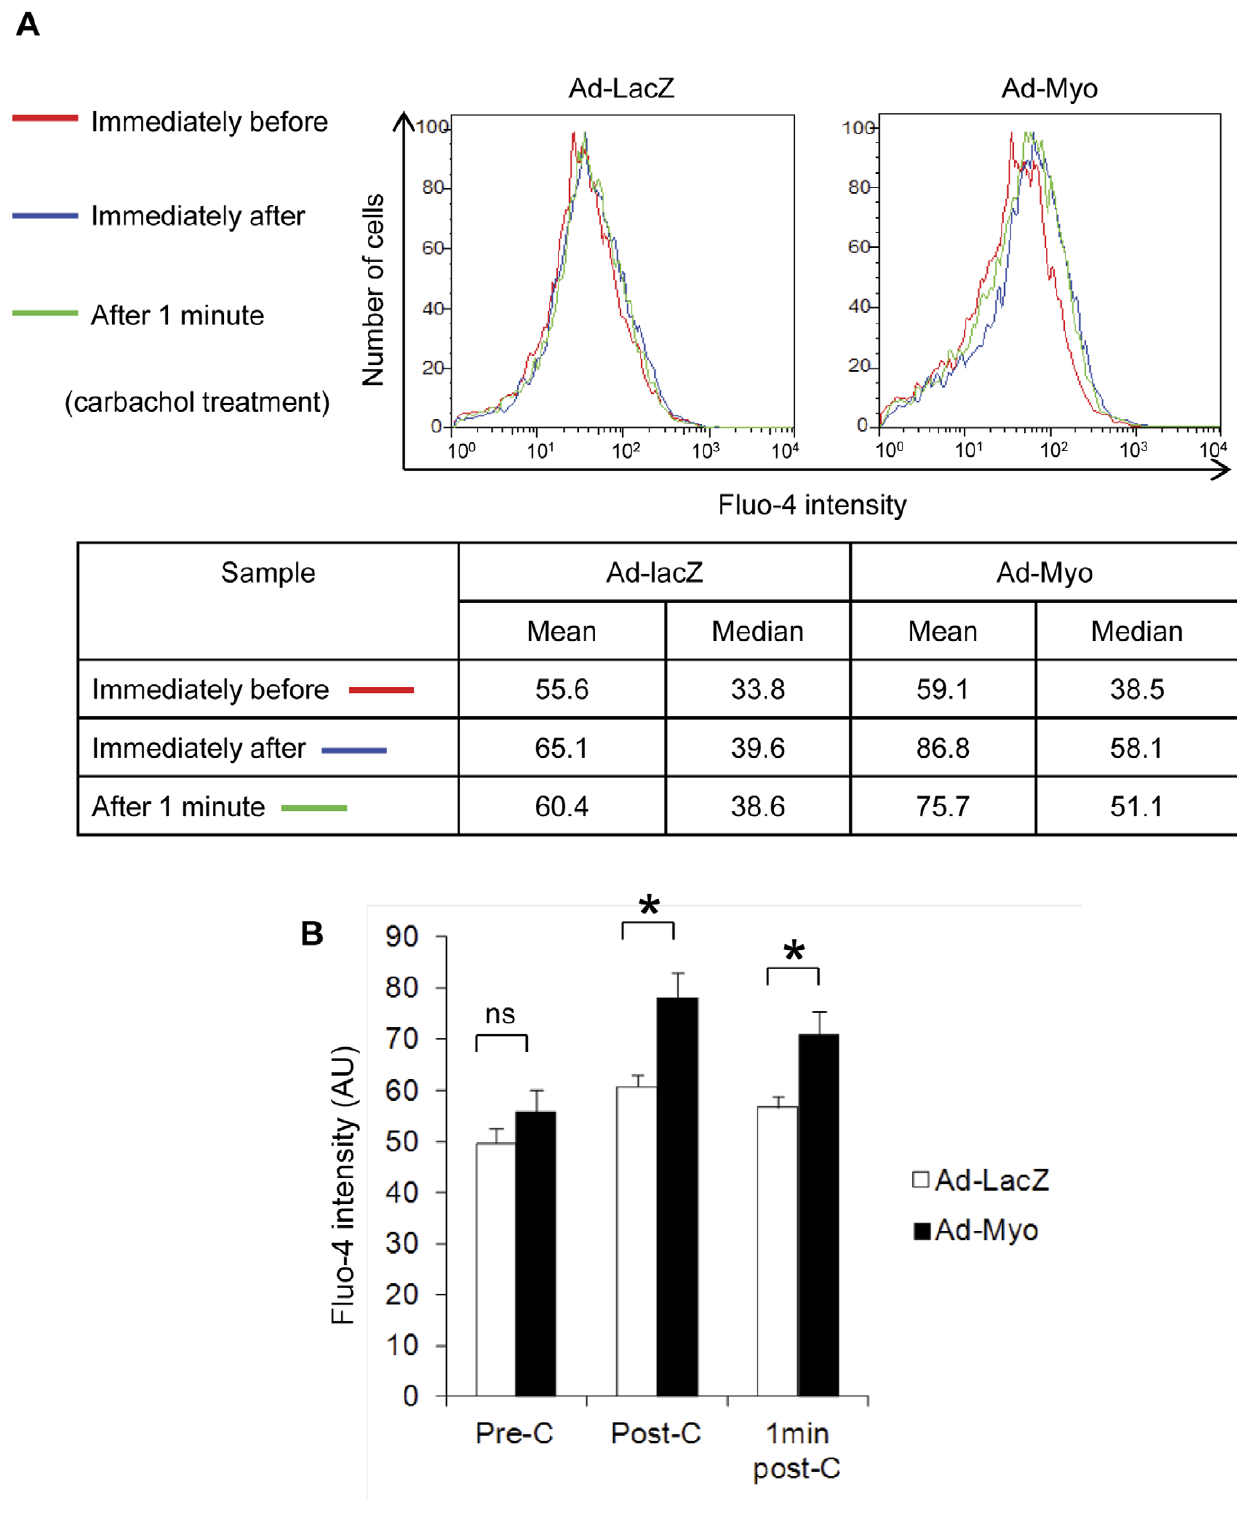
Figure 5. Myocardin promotes calcium influx in response to carbachol. Embryoid bodies were treated with Ad-LacZ or Ad-Myo from day 10 to day 28 and then dispersed into a single cell suspension. Cells were loaded with Fluo-4, a calcium sensitive fluorophore, and intracellular [Ca 2 + ] was measured by flow cytometry before and after the addition of the muscarinic agonist, carbachol in arbitrary units (AU). Representative data from a single experiment (A) and means of three studies (B) show significant increases in fluorescence following addition of carbachol. Error bars represent s.e.m., ns=not significant, *=p , 0.05, C=carbachol.